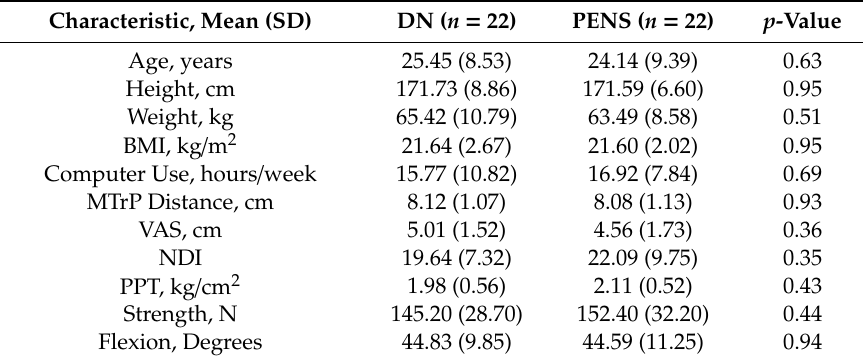
Figure 2. Flow diagram of subjects. PENS, percutaneous electrical nerve stimulation. Table 1. Baseline characteristics of the subjects ( n =